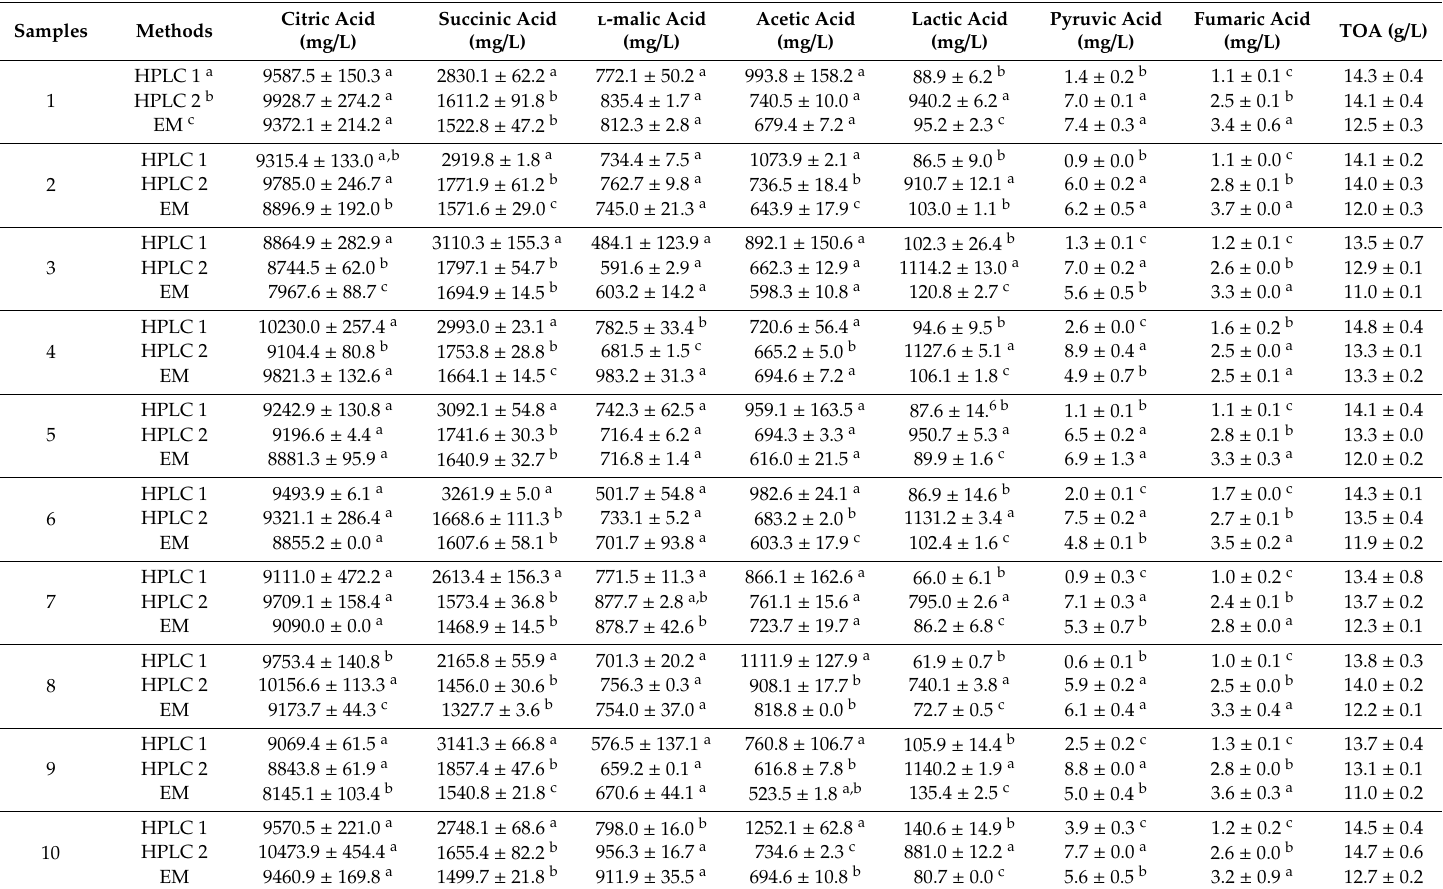
Table 2. Identification of organic acids with enzymatic